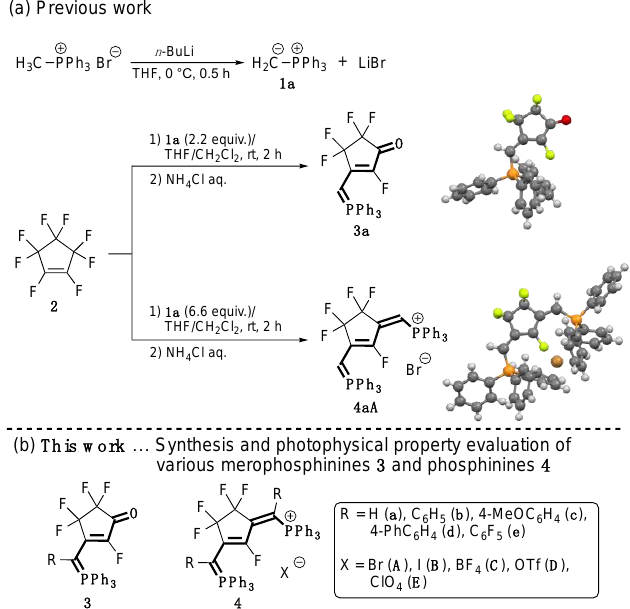
Figure 2. ( a ) Scheme showing the previously investigated reaction of octafluorocyclopentene with triphenylphosphonium methylide [18]; ( b ) The chemical structures of the fluorinated merophosphinine ( 3 ) and phosphinine ( 4 ) derivatives synthesized in this study.